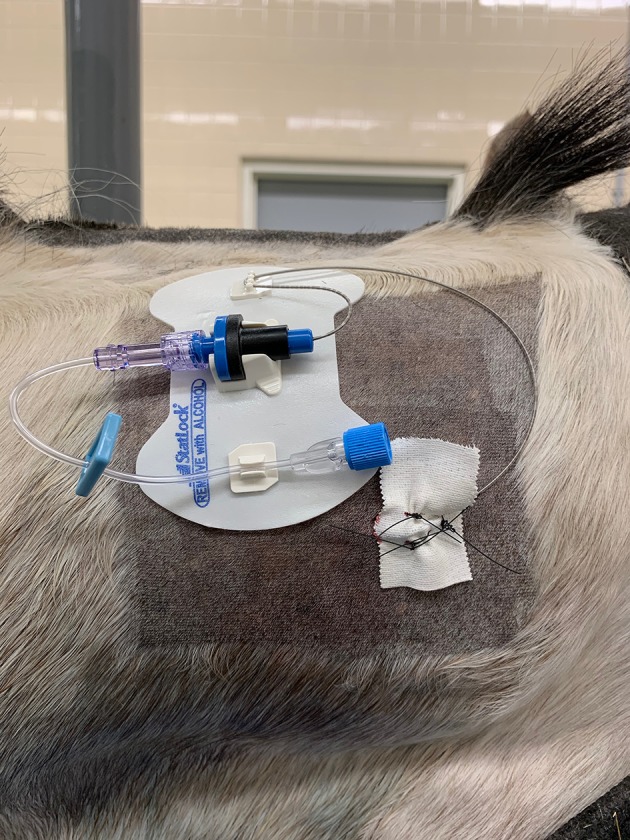
Photo showing the position of the catheter on the dorsolateral neck region fixed in place within a self-adhesive hub to the skin. The catheter insertion site is fixed to the horse using tape and three skin sutures. The head is to the right of the image (Horse 5).